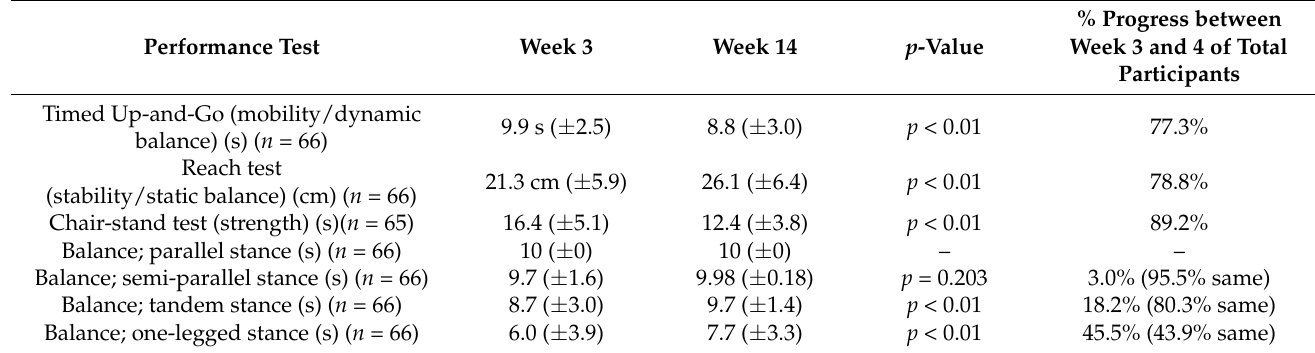
Table 2. Average scores for the performance tests.